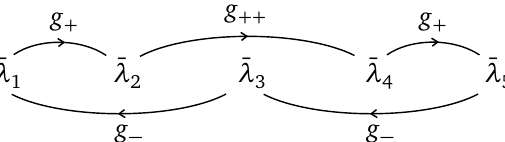
Figure 6: This cycle is the only one leading to a valid LU transformation in the case = { 0,1,1, − 1,0 } k b